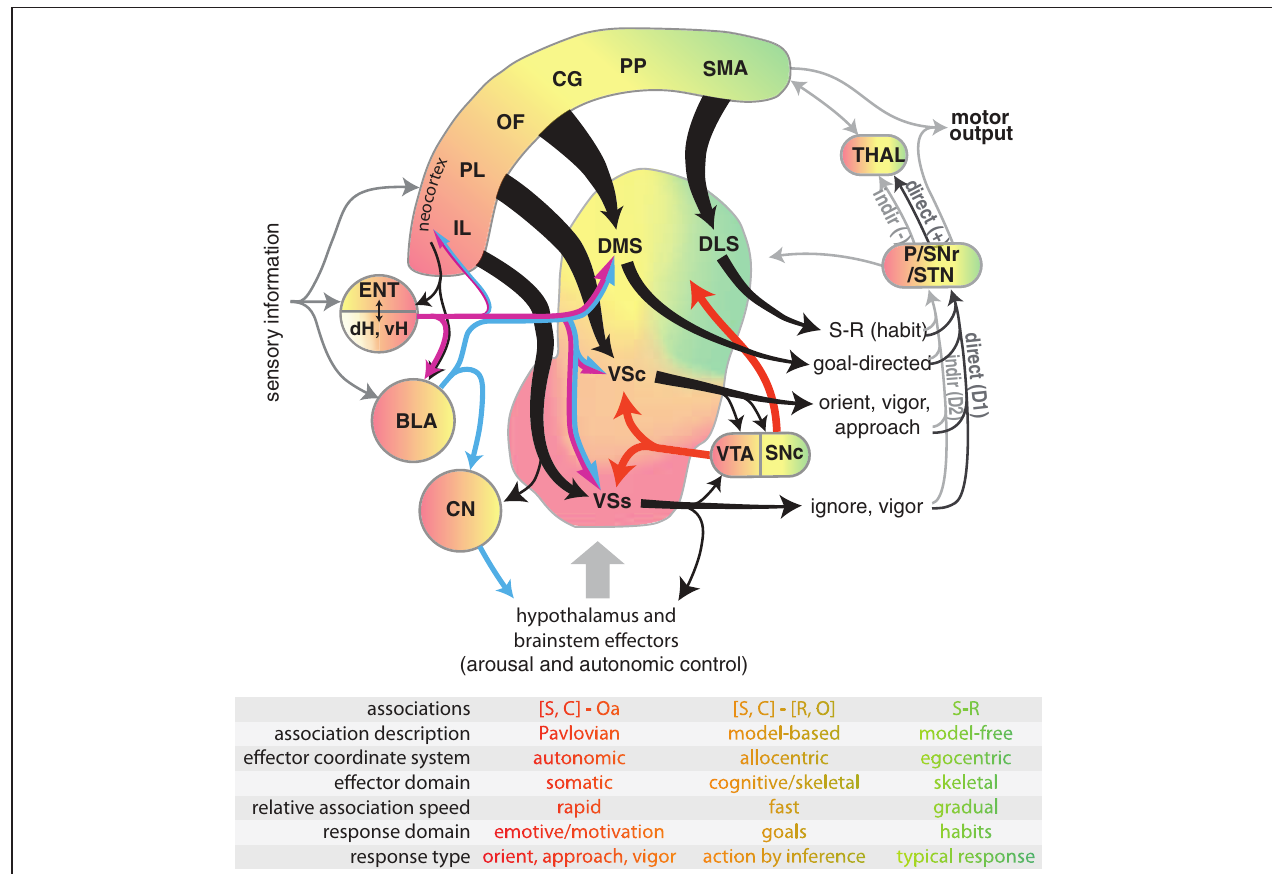
FIGURE 1 | Diagram illustrating select connectivity of brain structures involved in the voluntary control of rodent behavior. Four regions of rodent striatum are indicated by labels and color; the color gradient approximates the gradient of afferent projections (Voorn et al., 2004). Corresponding color in the other structures represents general projection topography. Note that ventral hippocampus has direct projections outside of the hippocampal formation, whereas the dorsal hippocampus does not (see text). Tapered arrows indicate highly convergent input. Output of the striatum can proceed through two distinct pathways to reach the thalamus and other targets: a “direct” pathway that has a disinhibitory effect ( + ), and an indirect pathway that has an inhibitory effect ( − ). These pathways are innervated by separate populations of medium spiny neurons in the striatum that predominantly express D1 (direct) or D2 (indirect) dopamine receptors. Projections from dopamine neurons in the VTA and SNc are shown in red.